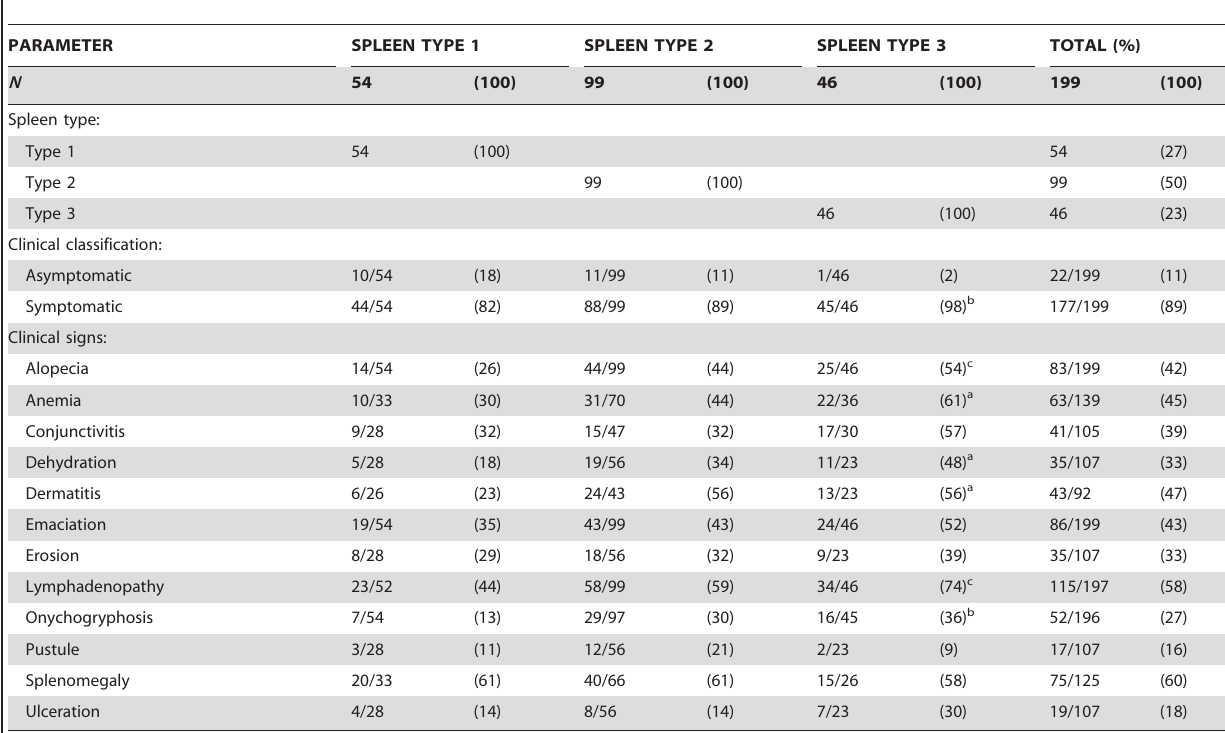
Table 3. Distribution of clinical signs associated with visceral leishmaniasis in dogs with evidence of infection by L. infantum and type 1 (normal) or type 3 (moderately to severely disorganized) splenic white pulp.